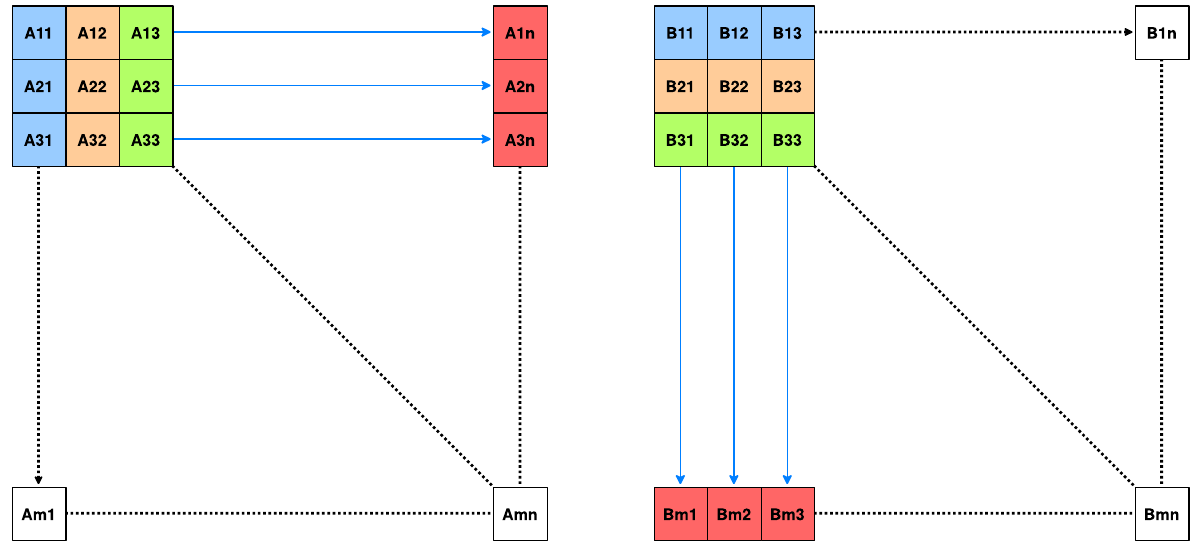
Figure 9. Schematic diagram of vectorized matrix multiplication strategy.